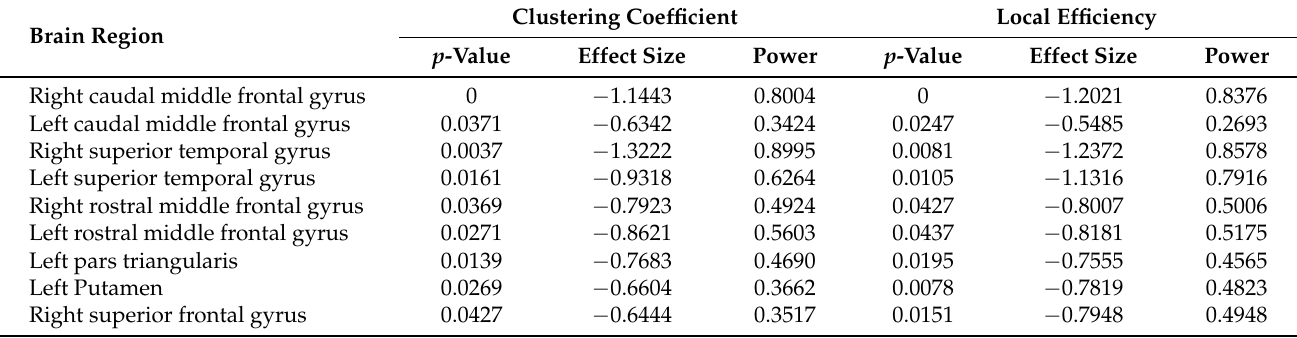
Table 4. Brain regions showing (uncorrected p -value < 0.05) altered clustering coefficient and local efficiency in the 0.12–0.25 Hz network.